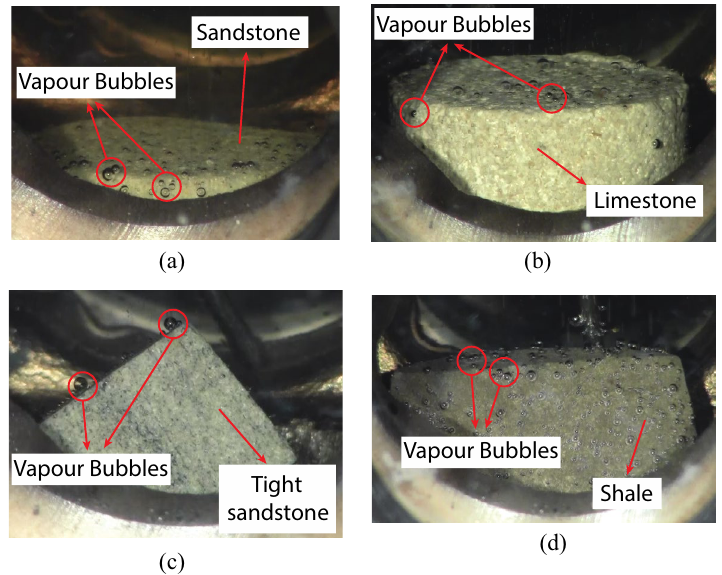
Figure 3. ( a ) Vaporization of pure heptane in sandstone at 137 ° C and 64.7 psi; ( b ) vaporization of pure octane in limestone at 163 ° C and 64.7 psi; ( c ) vaporization of pentane-heptane mixture in tight sandstone at 134 ° C and 114.7 psi; ( d ) vaporization of pentane-heptane-octane mixture in shale at 127 ° C and 64.7